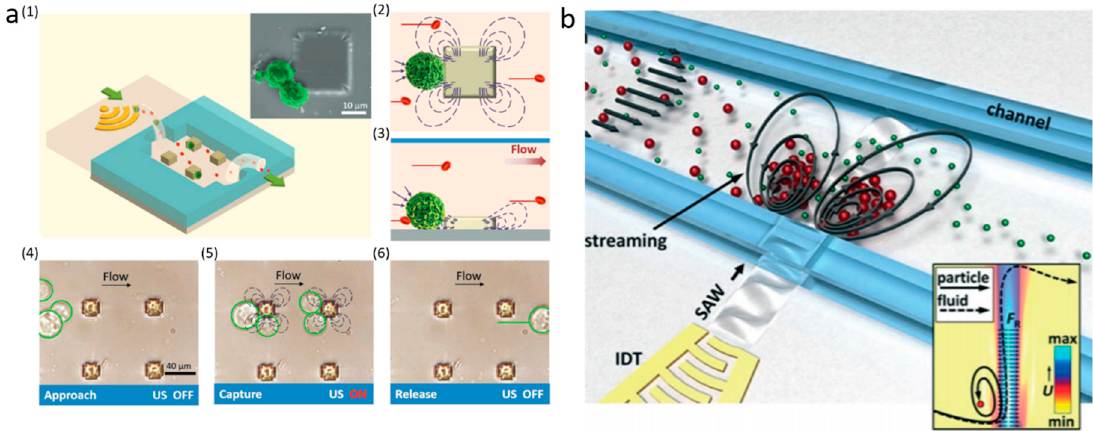
Figure 5. ( a ) Separation of CTCs from RBCs by acoustic radiation force and acoustic streaming. The actuated pillar array is able to trap the CTCs in a continuous flow. Reprinted with permission from reference [88]. ( b ) SAW-induced acoustic streaming separates human breast adenocarcinoma cells from RBCs. Reprinted with permission from reference [89].